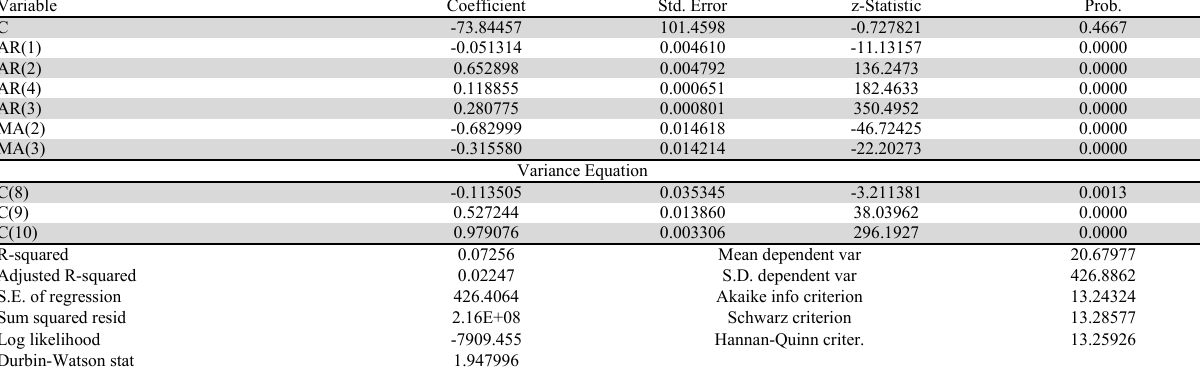
The results of EGARCH model on currency changes Variable